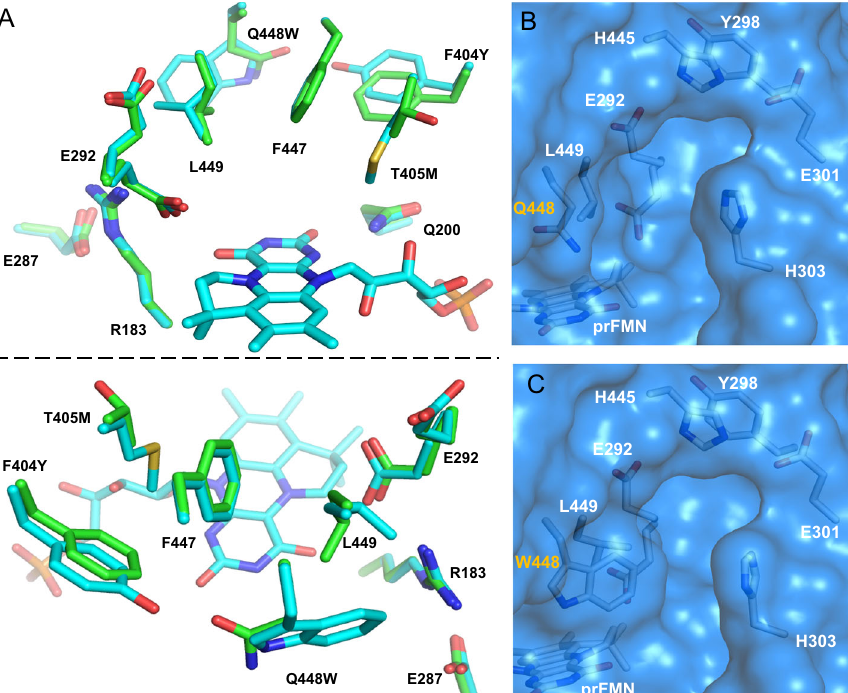
Fig. 2 Comparison of Ta Fdc and Ta FdcV. A Two views of the overlay of Ta Fdc wild-type (green, 7NEY [10.2210/pdb7NEY/pdb]) and Ta FdcV (blue, 7NF0 [10.2210/pdb7NF0/pdb]) active sites. Comparison of Ta Fdc B and Ta FdcV C binding pockets. The mobile L449 and E292 gate the entrance to the active site and the Q448W mutation narrows the entrance to the active